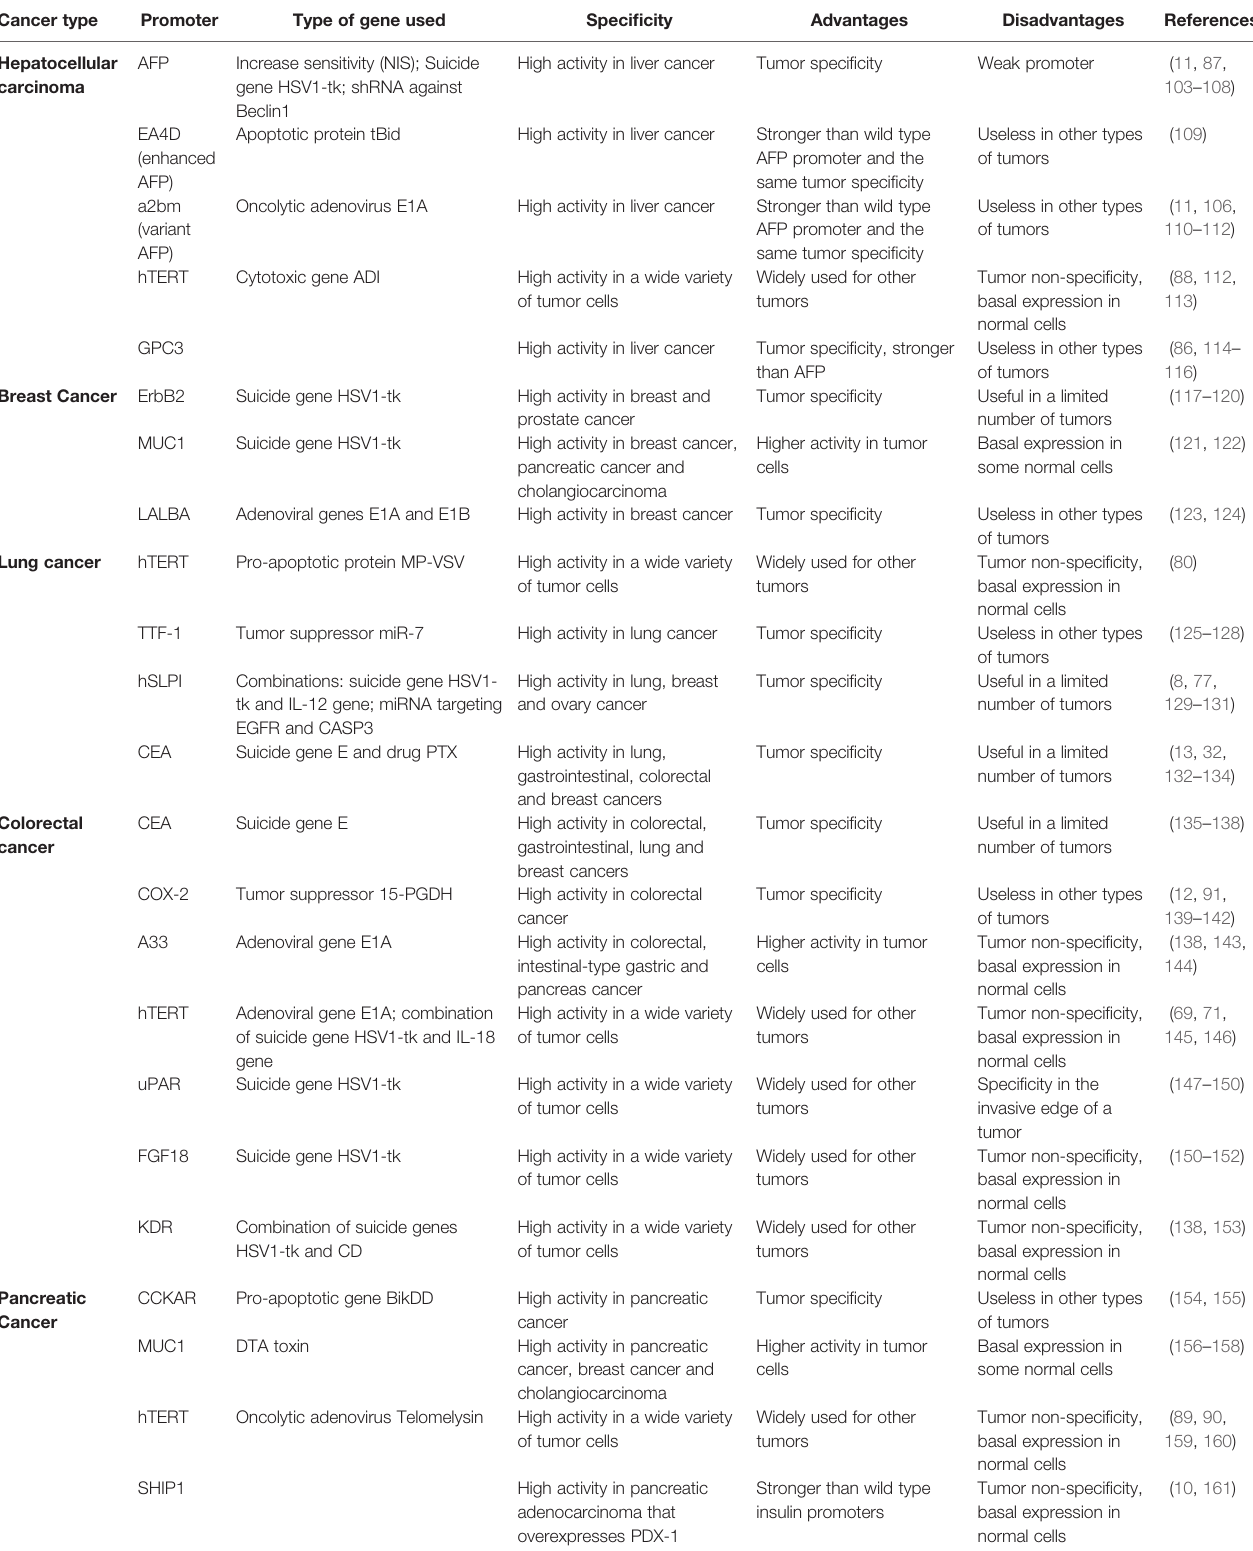
TABLE 1 | Features of tumor-speci fi c promoters and type of gene used in cancer gene